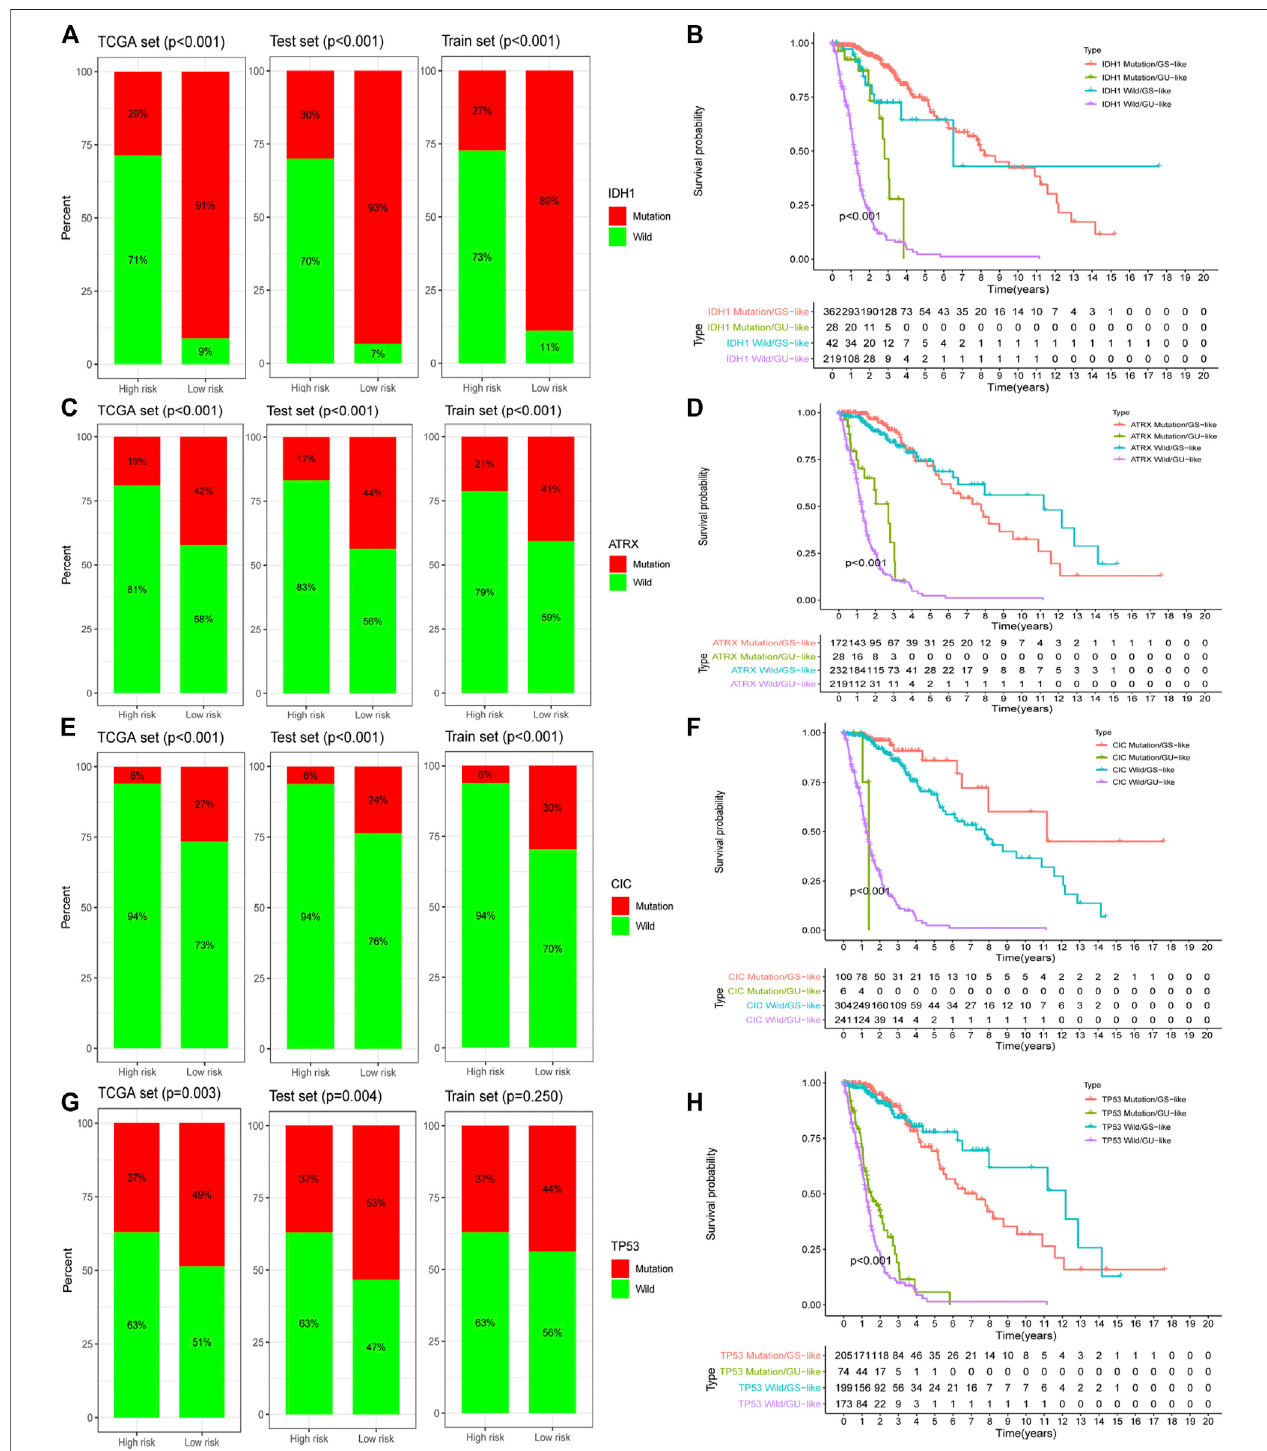
FIGURE 6 | The prognostic assessment ability of GILncSig is better than that of a gene mutation. Proportion of a gene mutation in high- and low-risk groups in the training set, testing set, and TCGA set: IDH1 (A) , ATRX (C) , CIC (E) , and TP53 (G) . Survival curves of patients based on the GILncSig scores under different gene mutation states: IDH1 (B) , ATRX (D) , CIC (F) , and TP53 (H) .